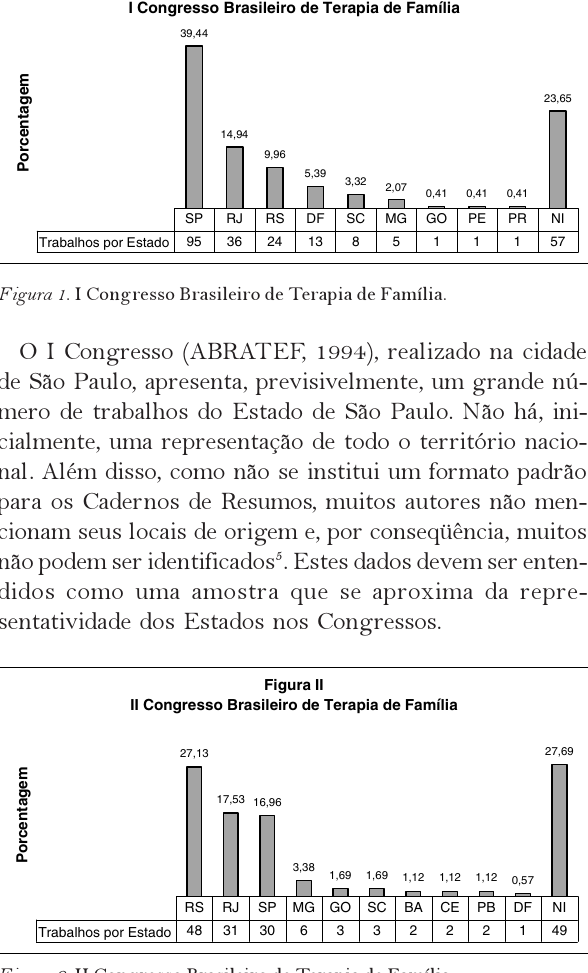
Figura 2 . II Congresso Brasileiro de Terapia de Família. No II Congresso (ABRATEF, 1996), realizado em Gra-